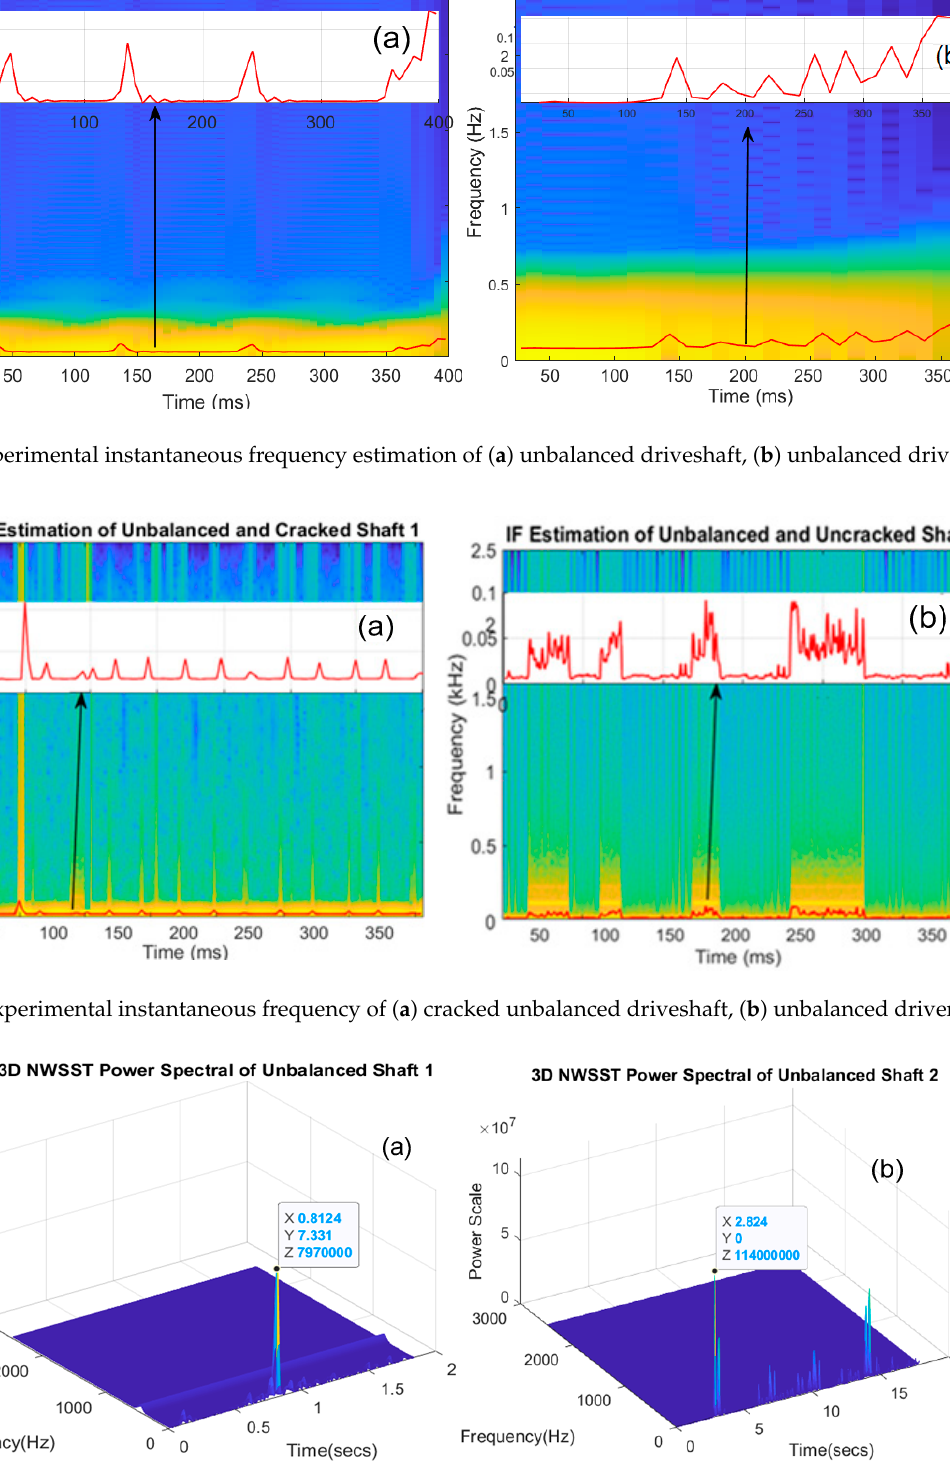
Figure 13. 3D experimental NWSST of ( a ) cracked unbalanced driveshaft, ( b ) unbalanced driven shaft. One of the remaining problems is the search of an adequate non-destructive diagnos- tic technique to identify the parameters of cracks by relating to the modifications of the modal behaviour of the considered structure (frequencies and specific deformities). Thus, all the experimentally collected results and data were transported and associated with a program developed in the MATLAB to extract the IF estimation and the NWSST response of the system. The estimated IF and the NWSST representation of the basic harmonic is presented in Figures 10–13. The results firstly indicated that the IF and NWSST methods are the least sensitive to noise. When the crack effect occurred, both the extracted IF of the response in the lateral direction of the shafts oscillated periodically near t = 55 ms (Figure 10c,d), which is the fundamental harmonic frequency. However, the structure of the esti- mated IF and the NWSST representation were not as organized as the obtained numerical results. The fluctuation of the flexible Hooke’s joint exerted a significant influence on the system dynamics (Figures 11 and 13). The excitations of the driveshaft at frequencies of 2 ω ,… 6 ω were very small in amplitude, whereas the excitations of the driven shaft ac- companied by frequencies of 4 ω ,…8 ω showed conspicuous magnitudes (Figure 11c,d) compared with those in Figure 13c,d. The magnitudes of the unbalanced driven shaft ex- citations were, therefore, independent of the joint angle but highly dependent on the ef- fects of the model parameters, such as rotational speed ratio, mass eccentricity, and inter- shaft connection. A comparison of these experimental results with the simulation has shown good agreement with results obtained in Section 5.2. Consequently, the effective- ness of the application of the NWSST method on the denoised signal facilitated the extrac-